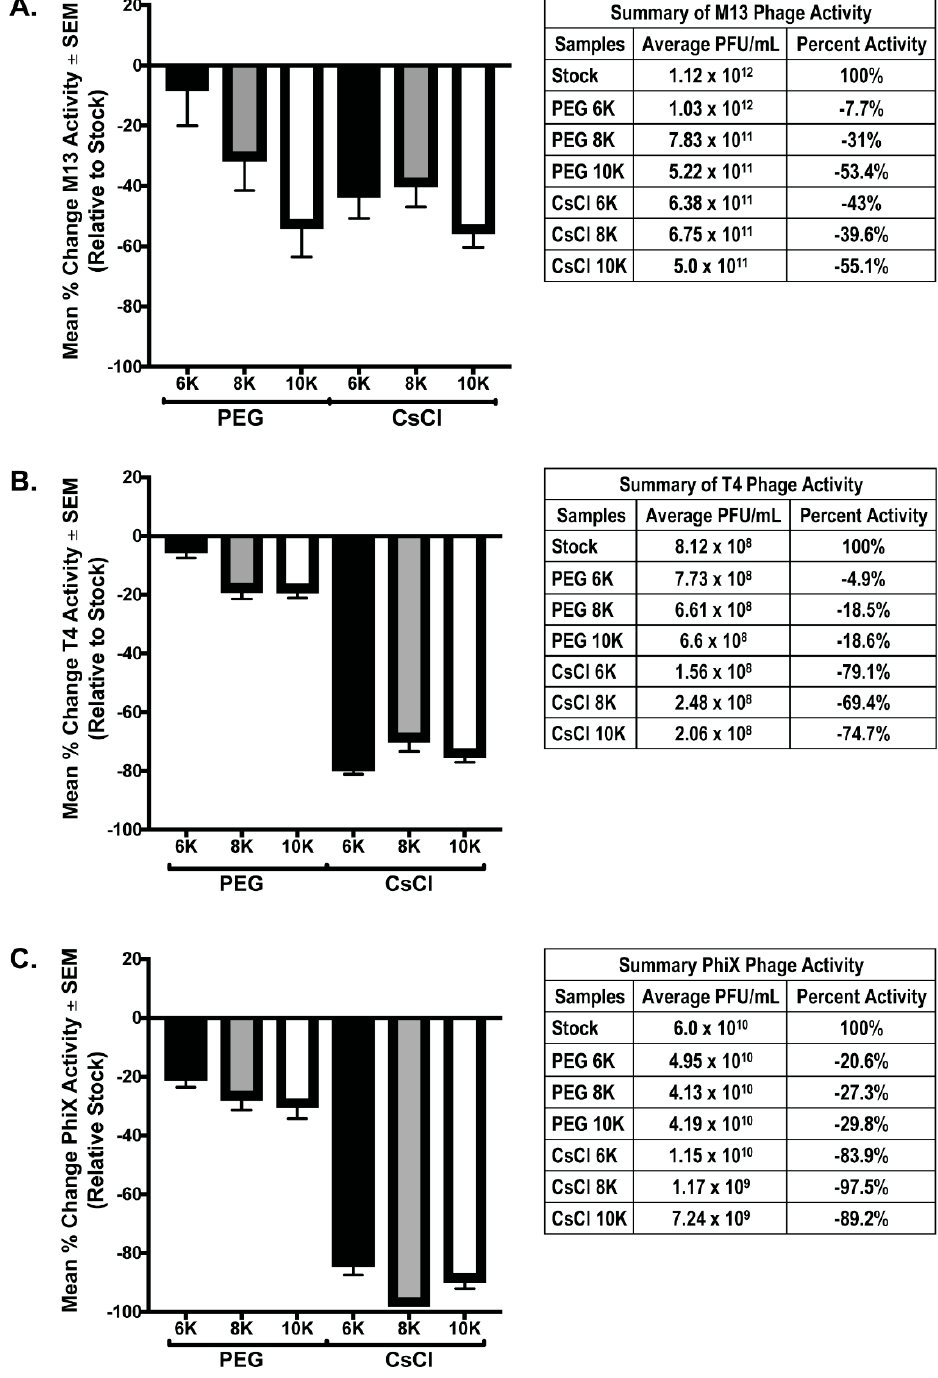
Figure 4. Phage activity decreases after PEG and/or CsCl purification. Graphical representation of the percent difference between the detected number of plaque forming units (active phage) and the expected number calculated from stock phage solutions for each individual phage preparation: ( A ) M13, ( B ) T4, and ( C ) Φ X. Tables accompanying each graph list numerical values for the respective bar and the stock phage activity value from which calculations were